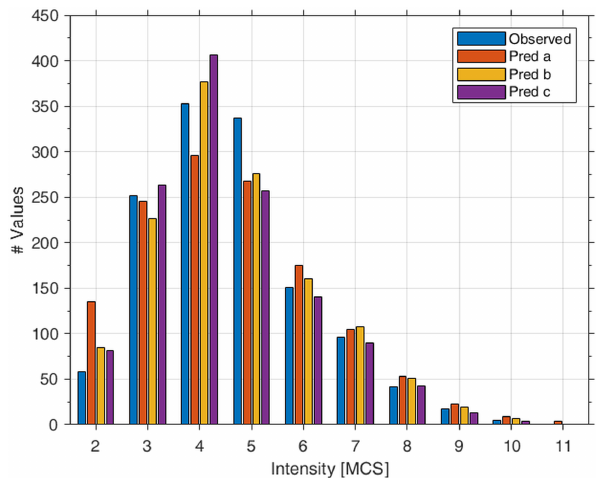
Figure 5. Observed (blue bar) and predicted number of intensity values for analysis a (orange bar), b (yellow bar) and c (violet